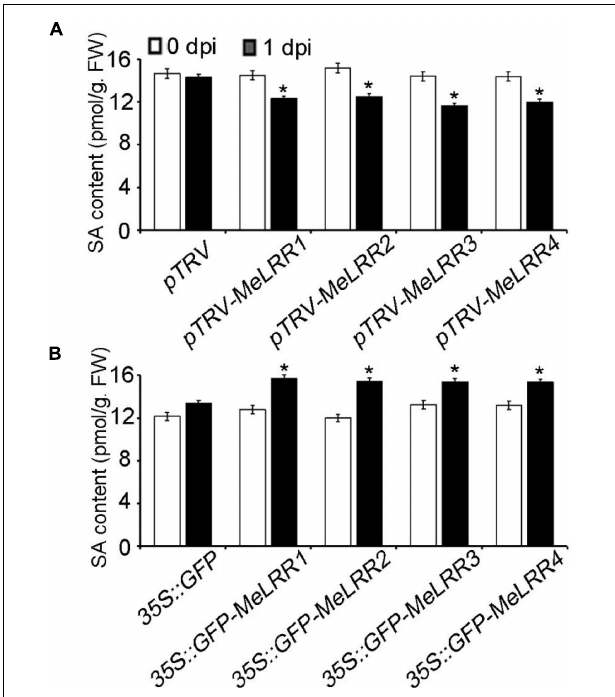
FIGURE 5 | The salicylic acid content in cassava. The SA content in MeLRR -silenced (A) and MeLRR -overexpression (B) cassava leaves. Transient expression of MeLRRs conferred immunity. At 0 and 1 d infection with Xam , the cassava leaves were used for analyzing the content of SA. Asterisks (*) indicate significant differences at p < 0.05. dpi is days